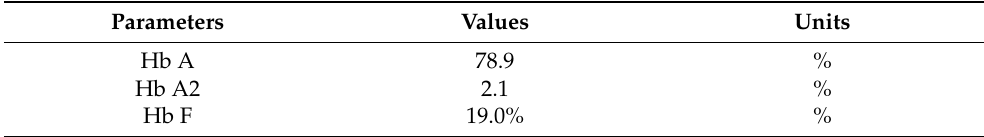
Table 3. Peripheral blood film. Report RBCs: dimorphic picture of normocytic and macrocytic cells, many teardrops poikilocytes, macro-ovalocytes, and no blast cells.